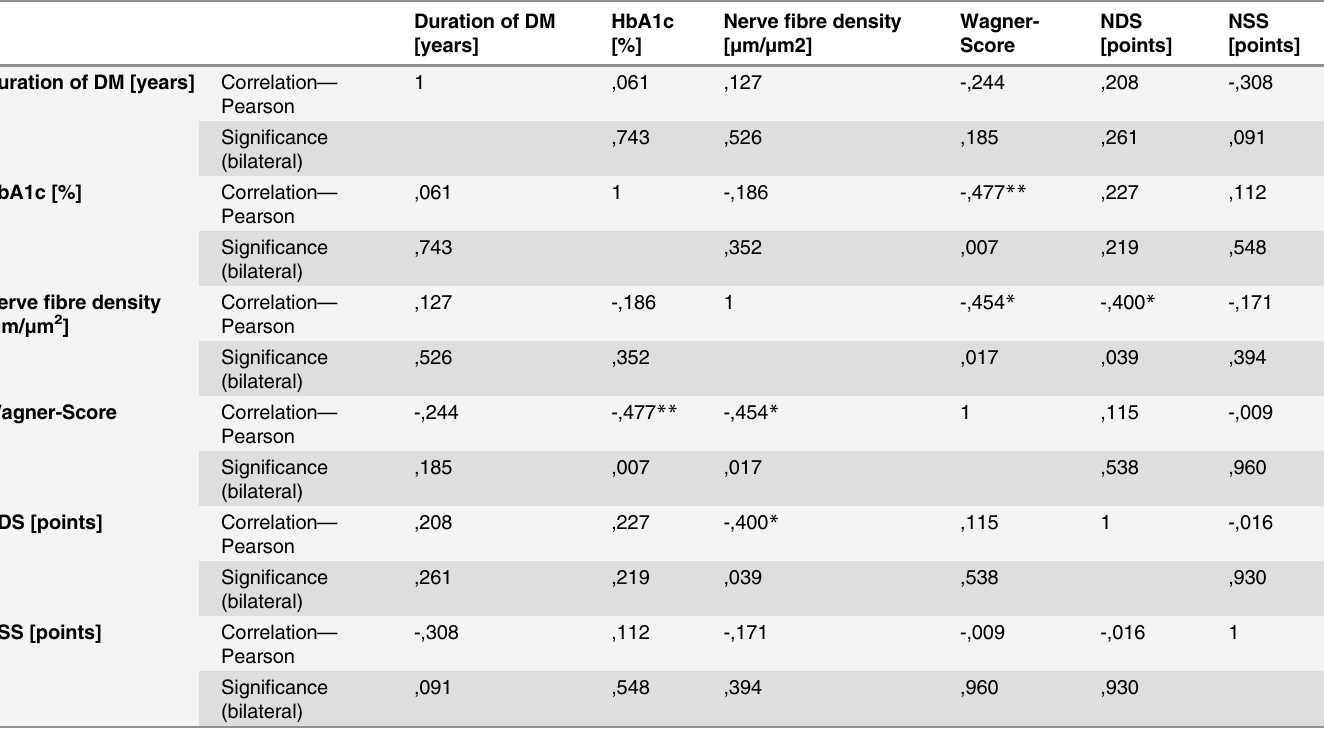
Table 2. Correlation between study parameters in diabetic patients.